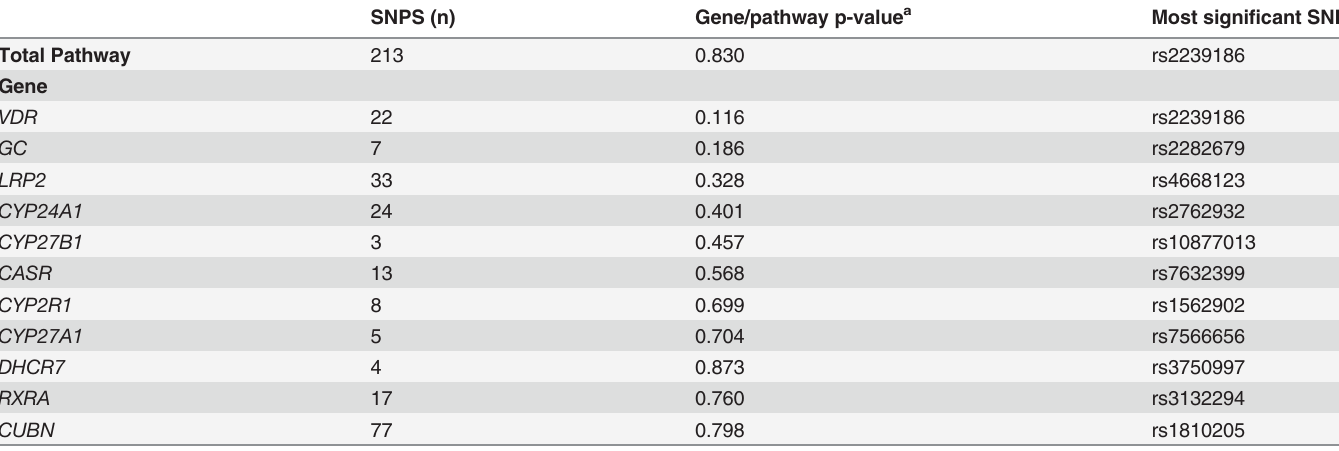
Table 1. Pathway analysis for risk of pancreatic cancer and gene sets in the vitamin D pathway (3,583 cases and 7,053 controls)